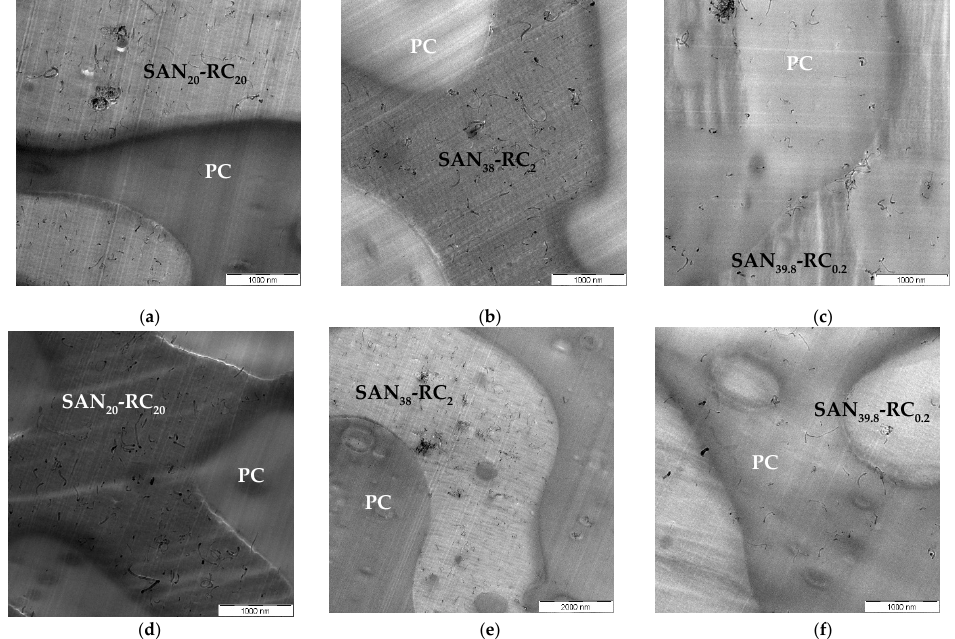
Figure 3. TEM images of PC 60 /SAN 40-x -RC x blends filled with Baytubes ® C150P ( a – c ) and C150HP ( d – f ): ( a ) PC 60 /SAN 20 - RC 20 blends and ( b ) PC 60 /SAN 38 -RC 2 blends showing Baytubes ® C150P (0.5 wt. %) localized in SAN-RC, ( c ) in PC 60 /SAN 39.8 - RC 0.2 blends Baytubes ® C150P (0.5 wt. %) stay in PC, ( d ) PC 60 /SAN 20 -RC 20 blends and ( e ) PC 60 /SAN 38 -RC 2 blends showing Baytubes ® C150HP (0.5 wt. %) localized in SAN-RC, ( f ) in PC 60 /SAN 39.8 -RC 0.2 blends Baytubes ® C150HP (0.5 wt. %) stay in PC.